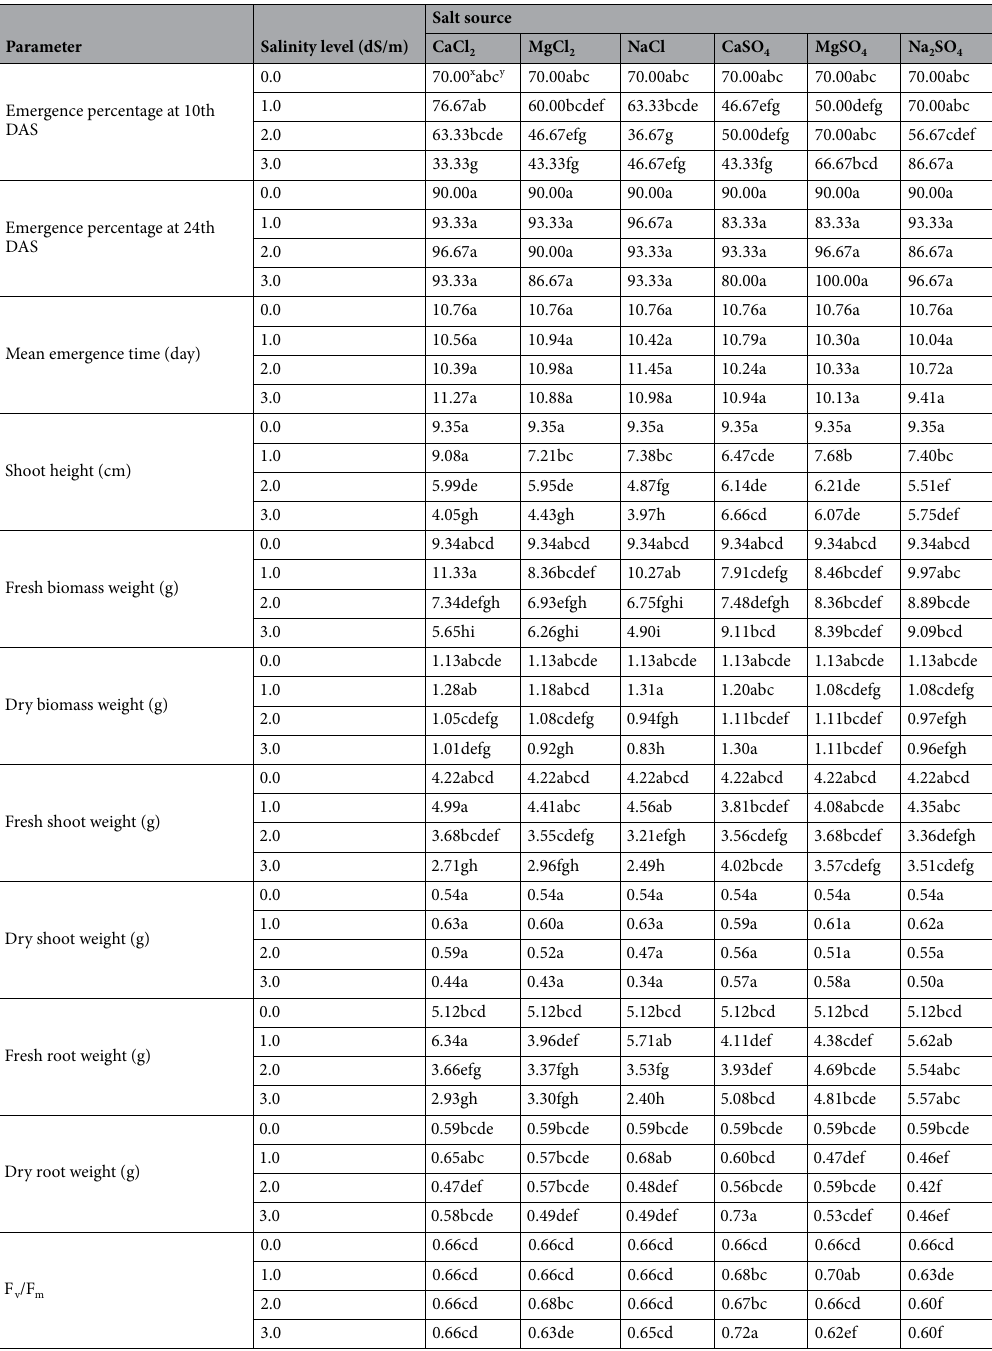
Table 6. The interaction effects of S × L level on III-29 faba bean genotype. x Each value is the mean of three replications. y Within salt source and salinity level of each parameter, means followed by the same letter are not significantly different at the 5% level according to Duncan’s multiple range